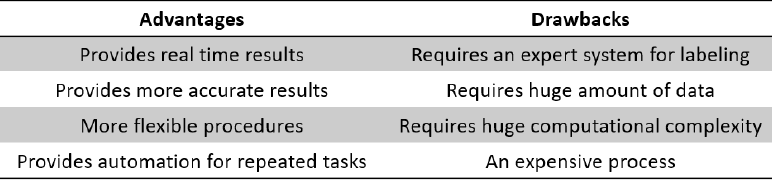
Figure 3. AI in smart inspection; advantages vs. drawbacks.